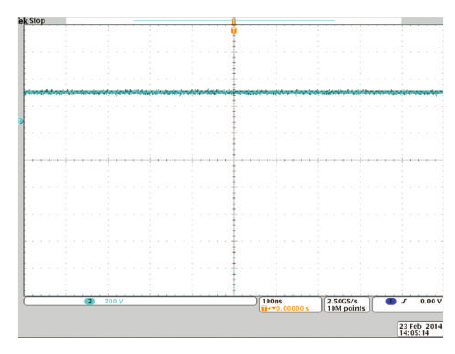
Figure 9: DC voltage wave.